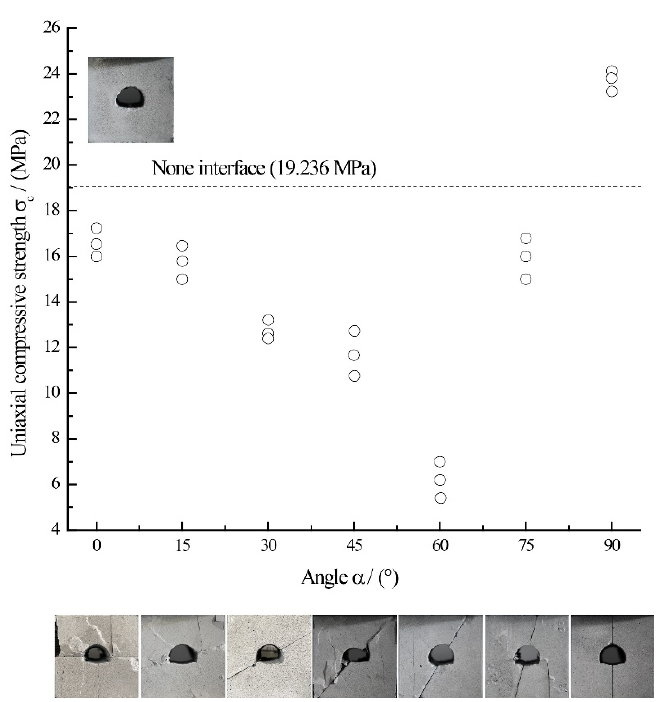
Figure 5. UCS with different dip